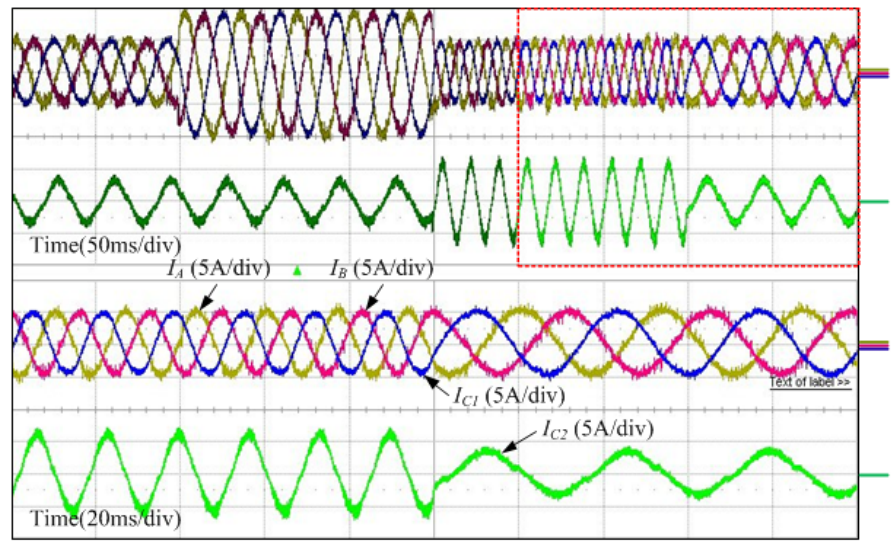
Figure 21. Experimental waveforms magnified for the third variation of the